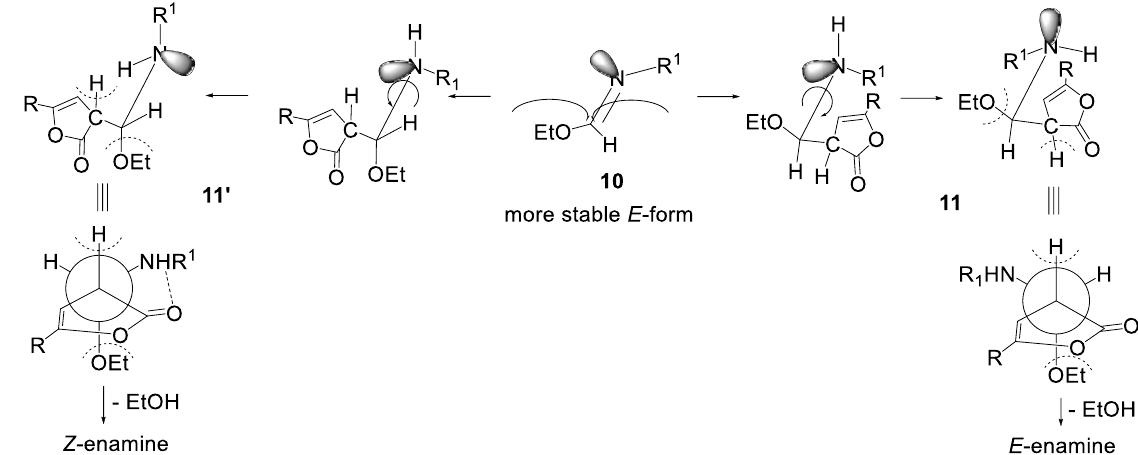
Scheme 6. Proposed stereochemical interpretation of the formation mechanism for 9a – f